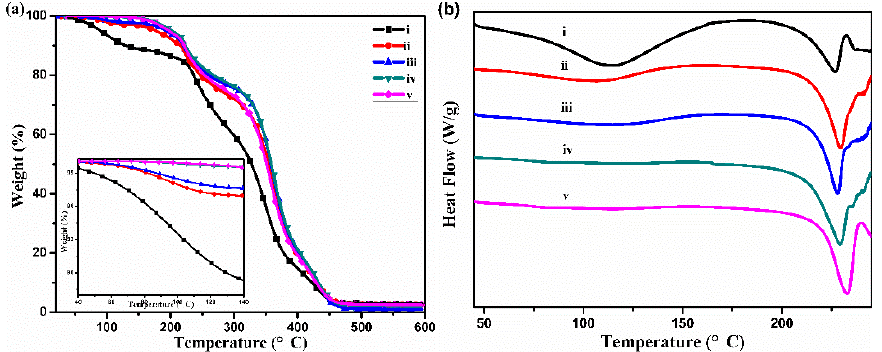
Figure 5. TG ( a ) and DSC curves ( b ) of triangular PVA fibers with different draw ratios: (i) 0; (ii) 2; (iii) 4; (iv) 6; (v) 7.